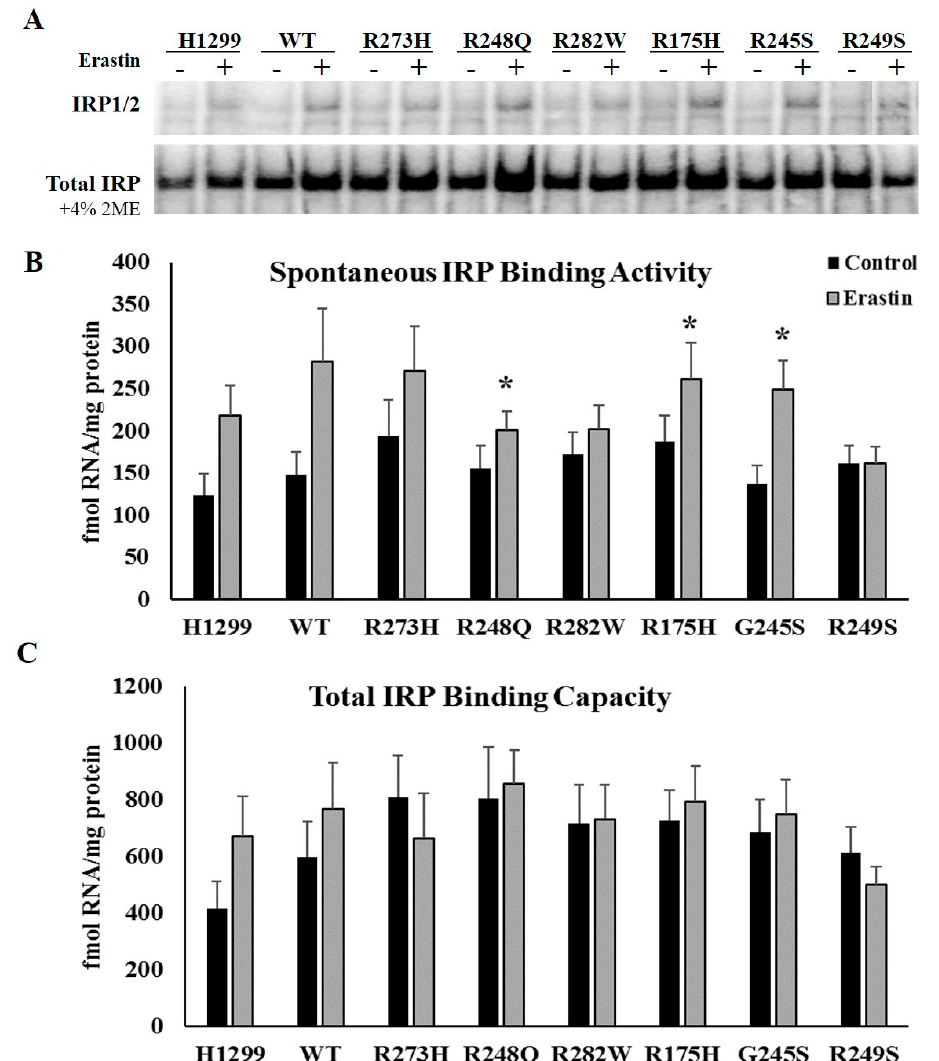
Figure 2. Erastin treatment increases iron regulatory protein (IRP)1/2 RNA binding activity in distinct mutant TP53-expressing subtypes. ( A , B ) Spontaneous IRP RNA binding was in tetracycline-induced WT and mutant TP53 ( n = 3–4 per cell type and treatment) expressing subtypes following treatment with DMSO (control) or 10 µM erastin (Erastin) for 24 h. * Denotes statistical differences from respective control, p < 0.05. ( A , C ) Total IRP RNA binding capacity was measured by assaying the cells under the same conditions in the presences of 2-mercaptoethanol. Error bars indicate SEM.